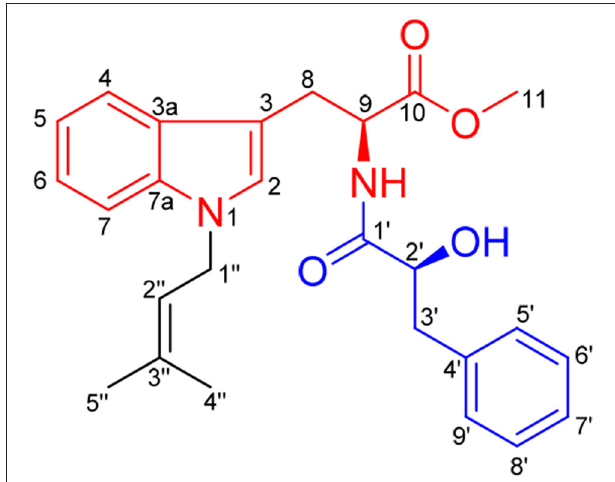
FIGURE 1 | Chemical structure of misszrtine A ( 1